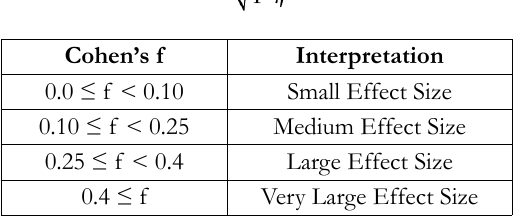
Table 4. Interpretation of Cohen’s value